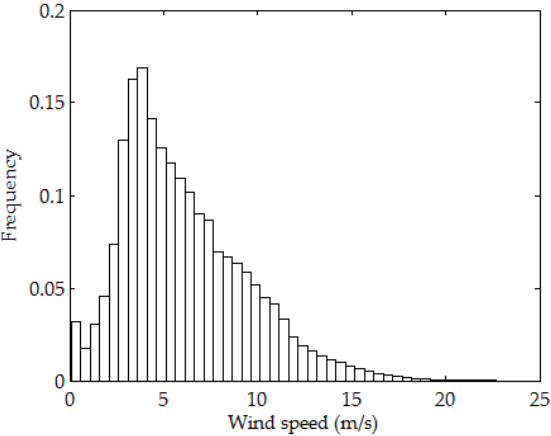
Figure 1. Wind speed frequency distribution histogram (Jun. 2009 to Jun. 2017).